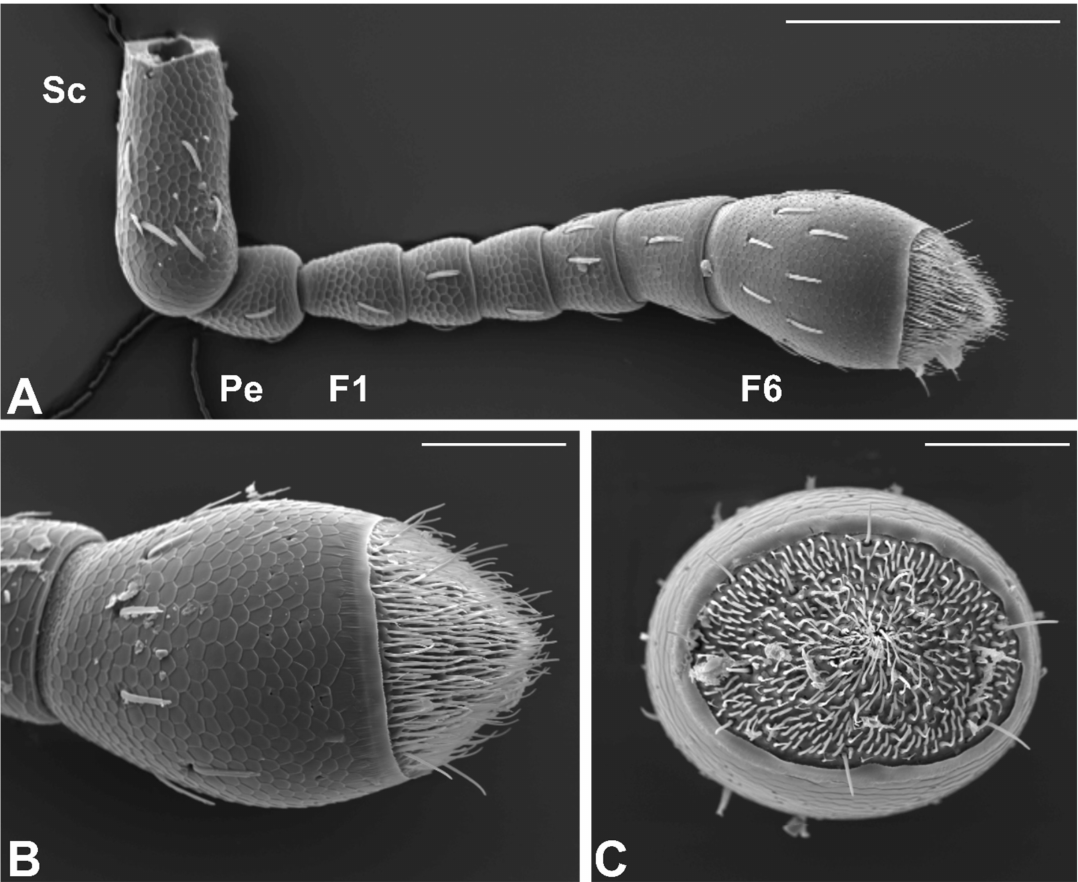
Figure 2. Scanning electron microscopy (SEM) micrographs of a female Sitophilus zeamais antenna. ( A ) General view of the whole antenna. The apical club-like antennomere is clearly visible on the right side of the picture. ( B , C ) detail of the apical antennomere in the lateral ( B ) and apical ( C ) view, respectively. The apical sensory area is clearly visible. F1, first antennomere of the funicle; F6, sixth antennomere of the funicle; Pe, pedicel; Sc, scape. Bar scale: ( A ) 200 µ m; ( B , C ) 50 µ m. Chaetic Sensilla Type 1 (CS1). These sensilla are characterized by a straight cuticular shaft inserted on to the antennal wall with a variable angle, but normally exceeding 45